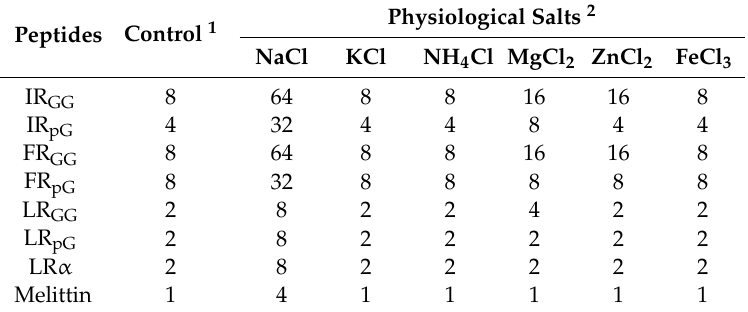
Table 3. The MICs ( µ M) of the designed peptides against E. coli ATCC25922 in the presence of physiological salts.